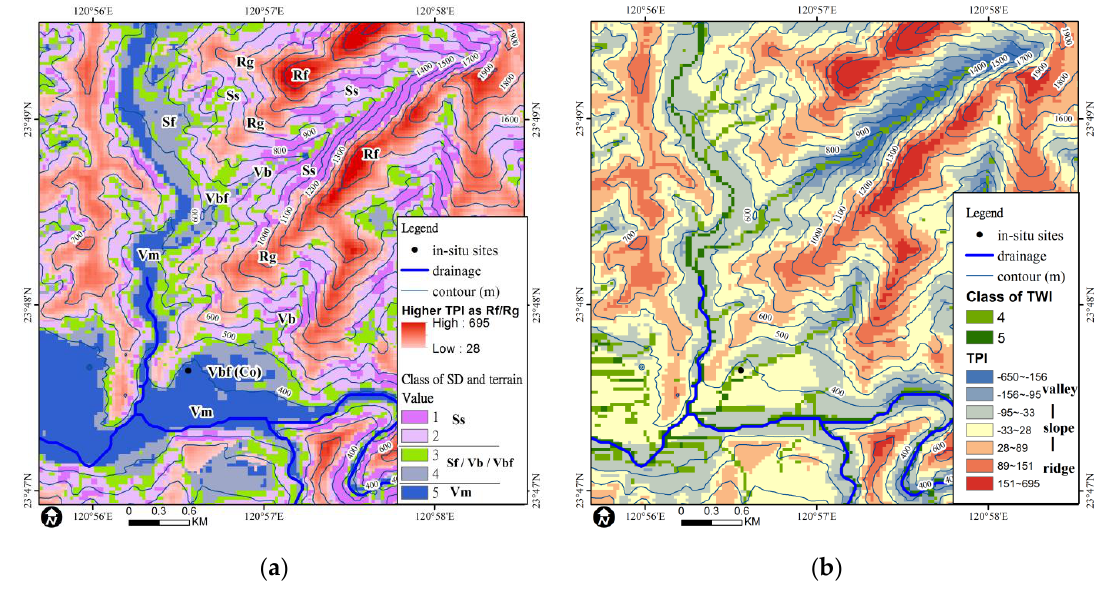
Figure 12. Geomorphic terrain near B099-11 site. ( a ) The seven categories of terrain are defined as near roof (Rf), at ridge (Rg), steep slope (Ss), flat slope (Sf), valley or creek bottom (Vb), alluvial fan of downstream the valley (Vbf), and main riverbed deposit (Vm). ( b ) The distribution of TPI and TWI.